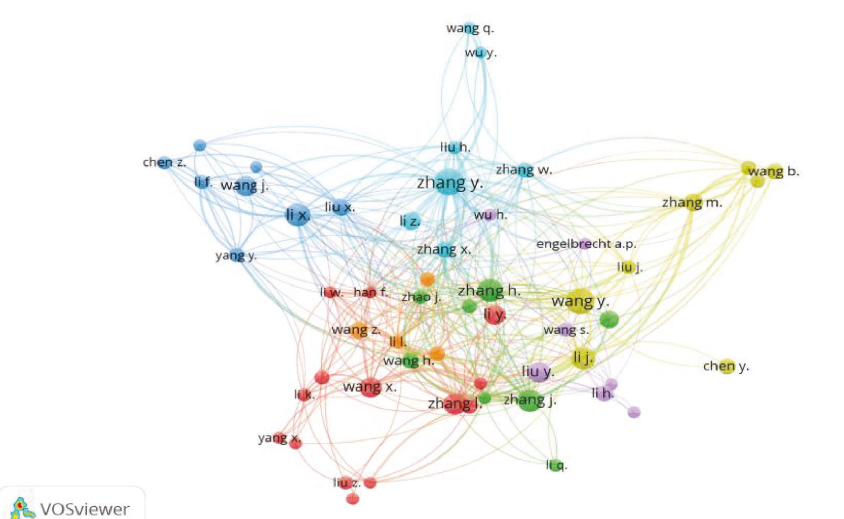
Figure 12: Network visualization map for the author-based citations on PSOA research.